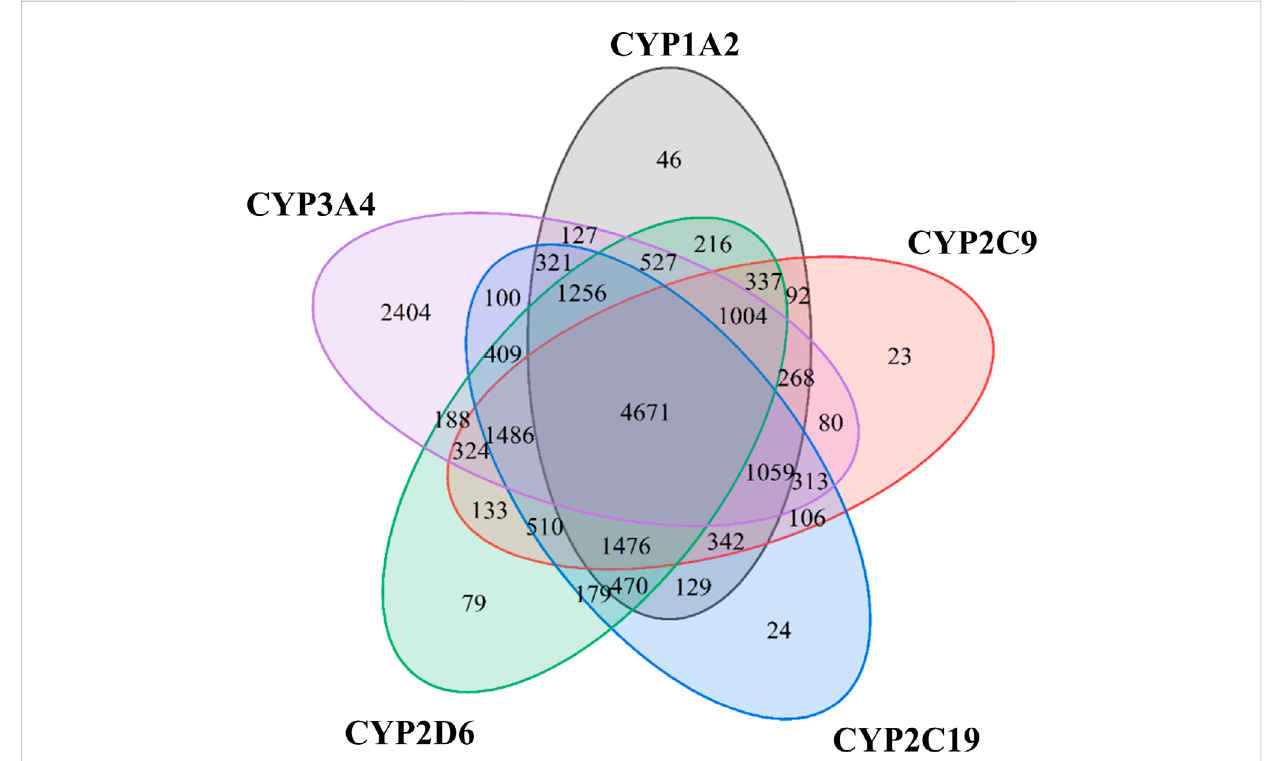
FIGURE 2 The data occupation distribution for the fi ve isoforms in the CYPs modelling